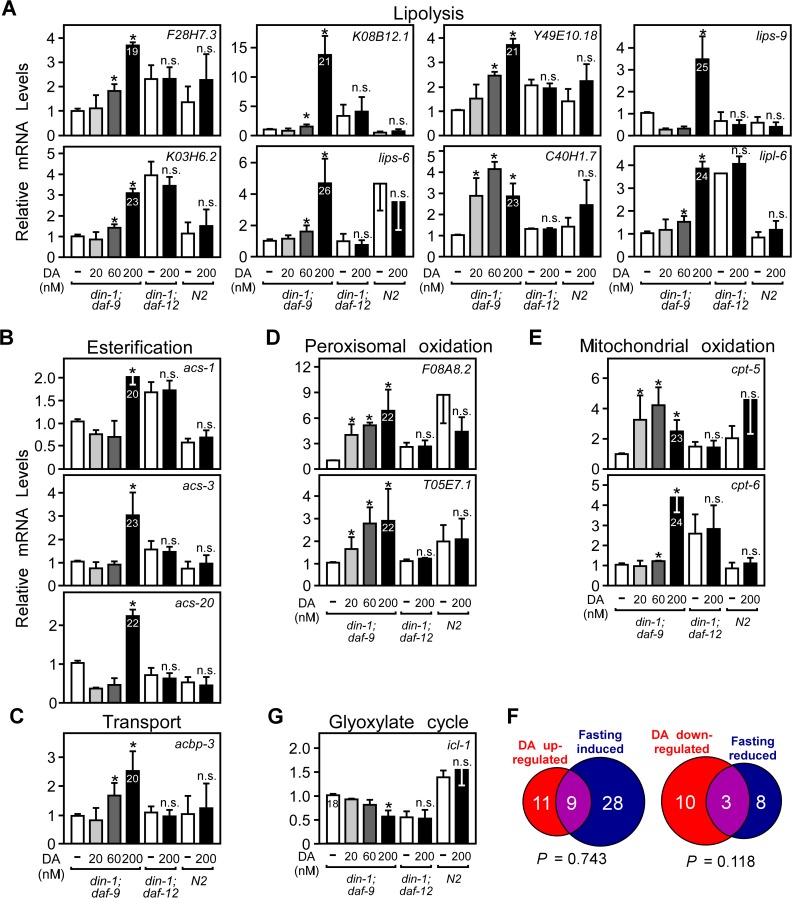
Regulation of fat utilization genes by DAF-12 in C. elegans.(A–E, G) Fatty acid metabolic gene expression in L3 worms. Synchronized L1 larvae were grown in the presence of vehicle or the indicated concentrations of DA for 22.5 hrs and mRNA expression was quantitated by qPCR. Numbers in bars refer to Ct values. (F) Comparison of DAF-12 and fasting regulated metabolic genes. *P< 0.05 by Student’s t-test comparing vehicle to DA treatment (n = 4 ± S.D.), n.s., not significant. Vehicle, ethanol; DA, Δ7-dafachronic acid.